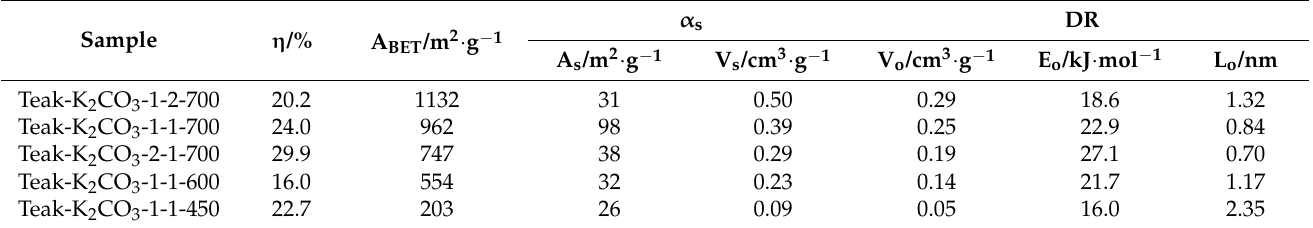
Table 2. Textural characteristics of activated carbons produced from Tectona Grandis sawdust, at different temperatures, by chemical activation with K 2 CO 3